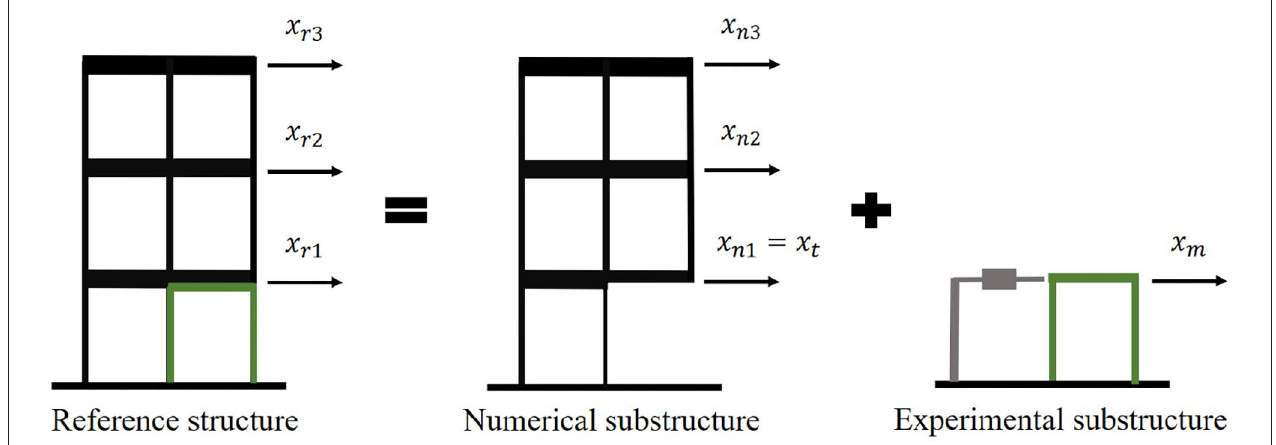
FIGURE 2 | Reference structure and